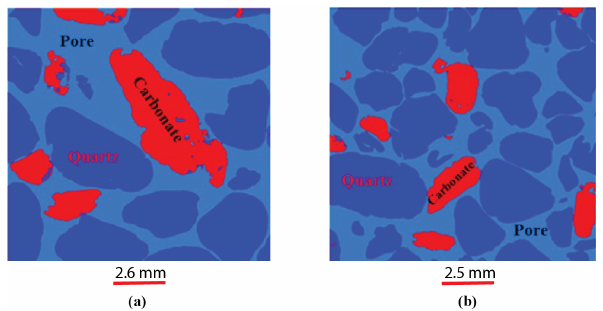
Figure 6. Three-phase watershed segmentation of the sand samples: (a) Scarborough; (b)